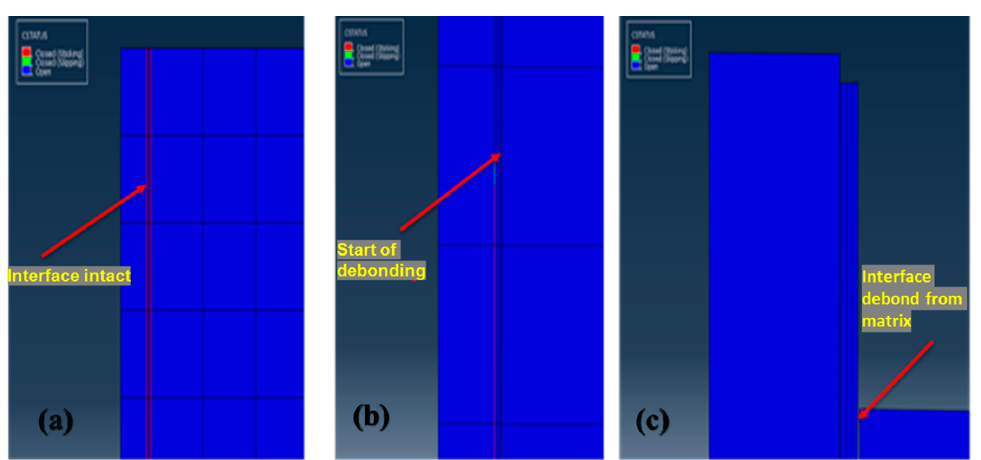
Figure 10. Finite element modeling of fiber pull-out and debonding: ( a ) Represents initial stage of pull-out where the red part indicates the interface is intact, ( b ) represents the middle stage of simulation where the absence of red spots indicates debonding, and ( c ) represents the debond between the matrix and interface.